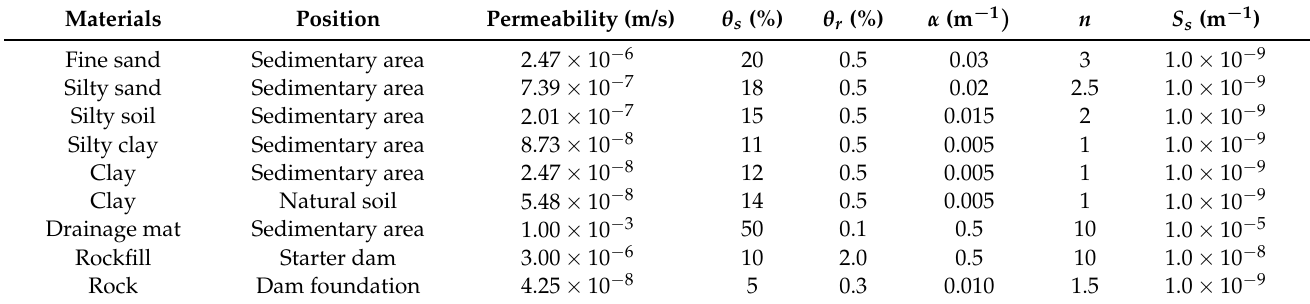
Table 1. The material properties of the tailings dam for verification.